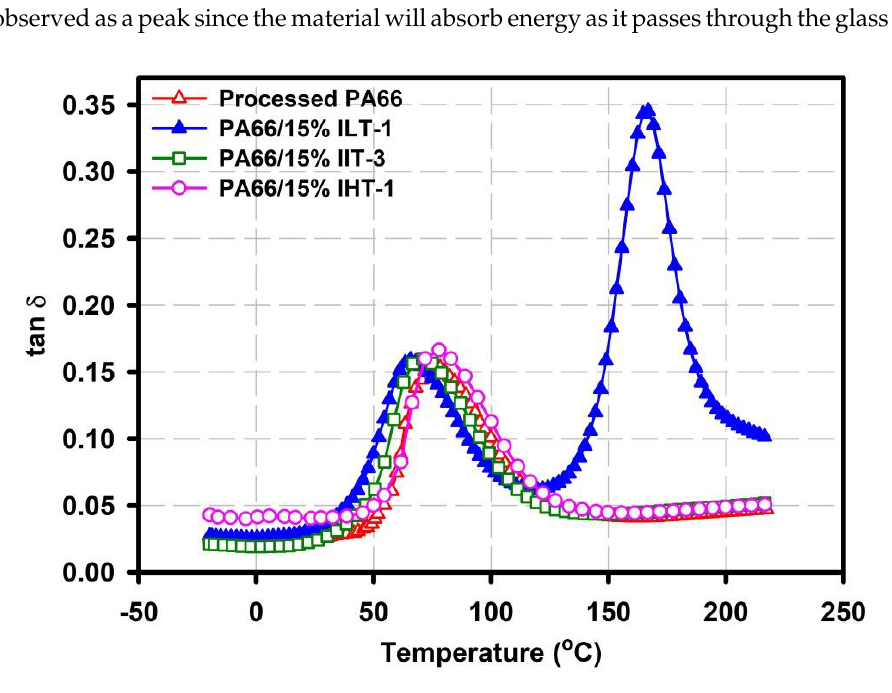
Figure 2. Loss factor tan δ curves as a function of temperature for the studied PA66 / P-glass systems and processed virgin PA66.